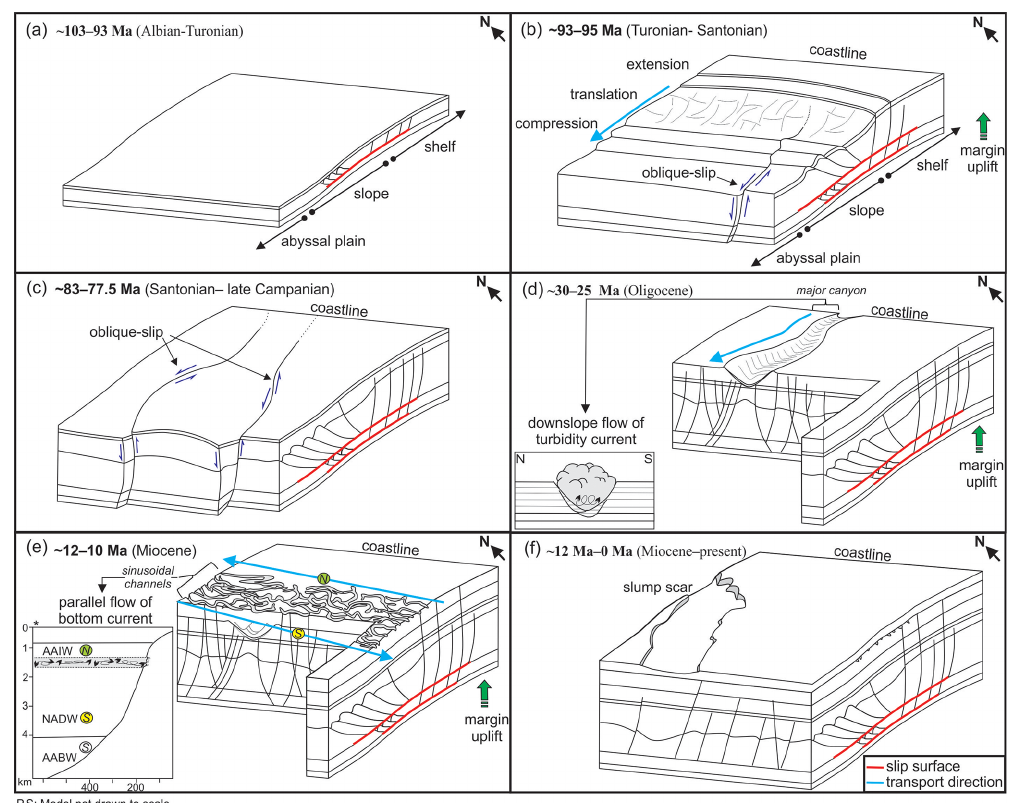
Figure 12. Temporal model of the evolution of the deep-water Orange Basin from the Late Cretaceous DWFTB system to the mass transport complexes of the Cenozoic. For a detailed explanation the reader is referred to Sect. 5.4. Insert diagram in panel (e) , denoted by ∗ , is modified after Weigelt and Uenzelmann-Neben